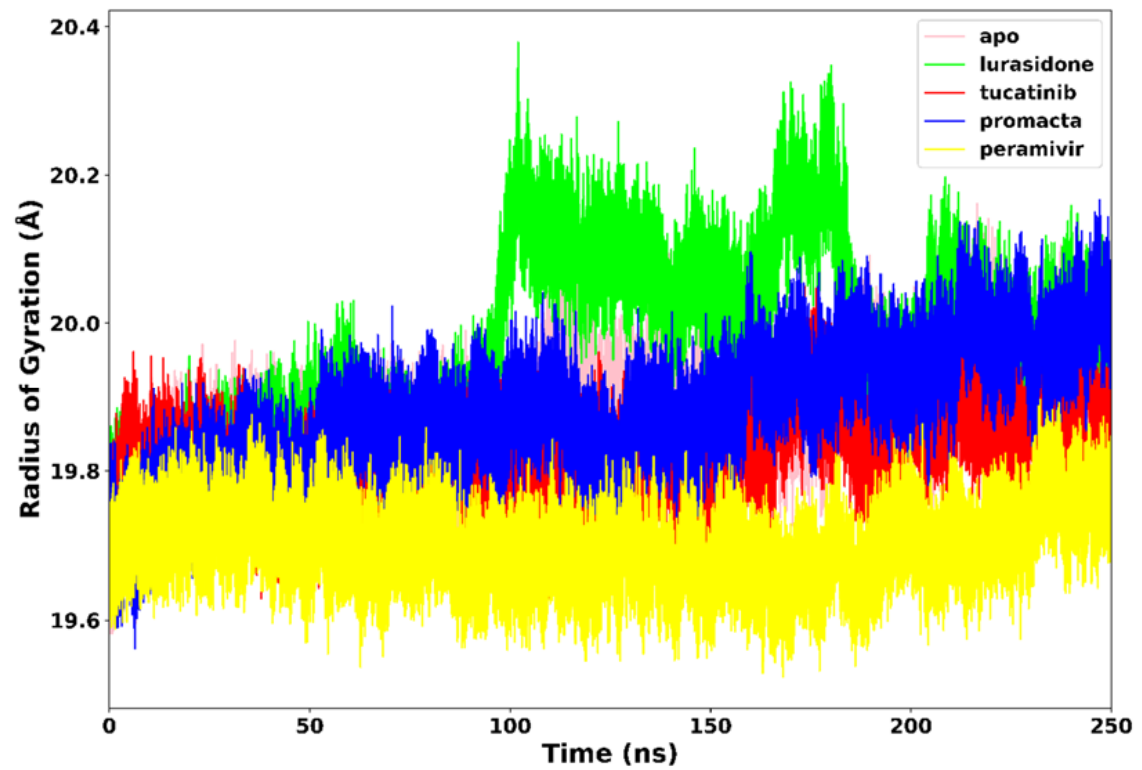
Figure 6. Radius of gyration trajectories of NA–ligand complexes during 250 ns simulations.